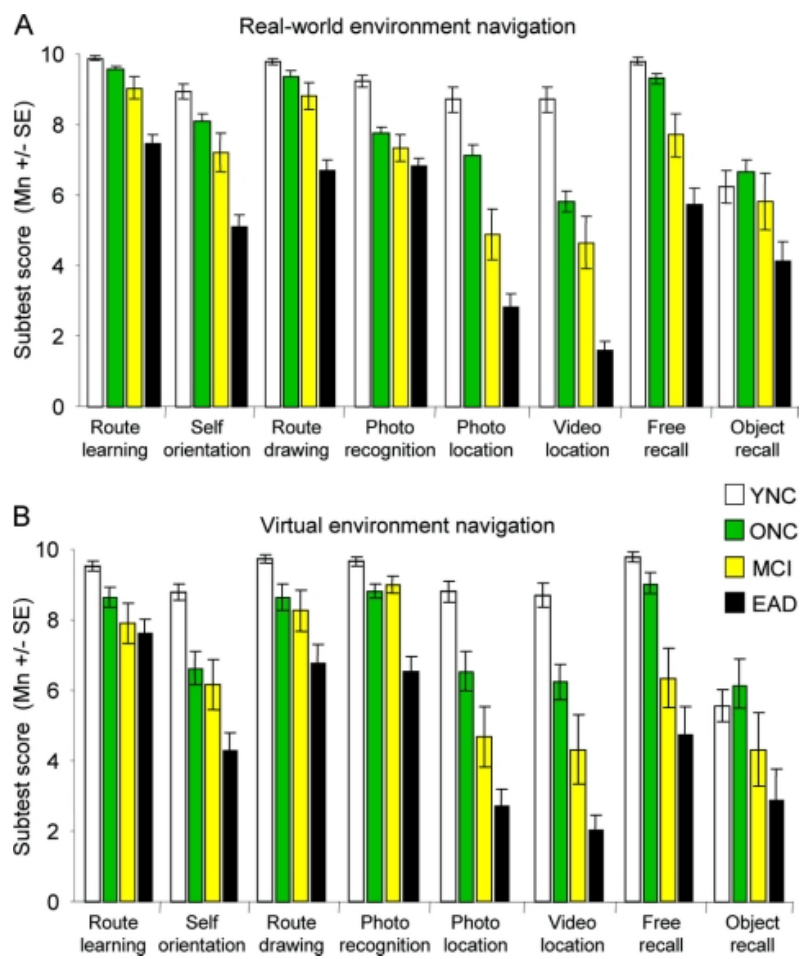
Figure 5. Across subject groups,the same pattern of relative performance was apparent on subtests, as was seen on total test scores; poorer performance from young normal controls (YNC) to older normal controls (ONC), to patients with mild cognitive impairment (MCI), and to patients with early Alzheimer disease (EAD). The real-world and virtual environments yielded similar patterns and magnitudes of differences across subject groups (young normal controls (YNC), older normal controls (ONC), patients with mild cognitive impairment (MCI), and patients with early Alzheimer disease (EAD)). ( A ) Real-world environment navigation; ( B ) virtual environment navigation. The photo and video location subtests yielded the lowest mean scores from both the MCI and AD groups